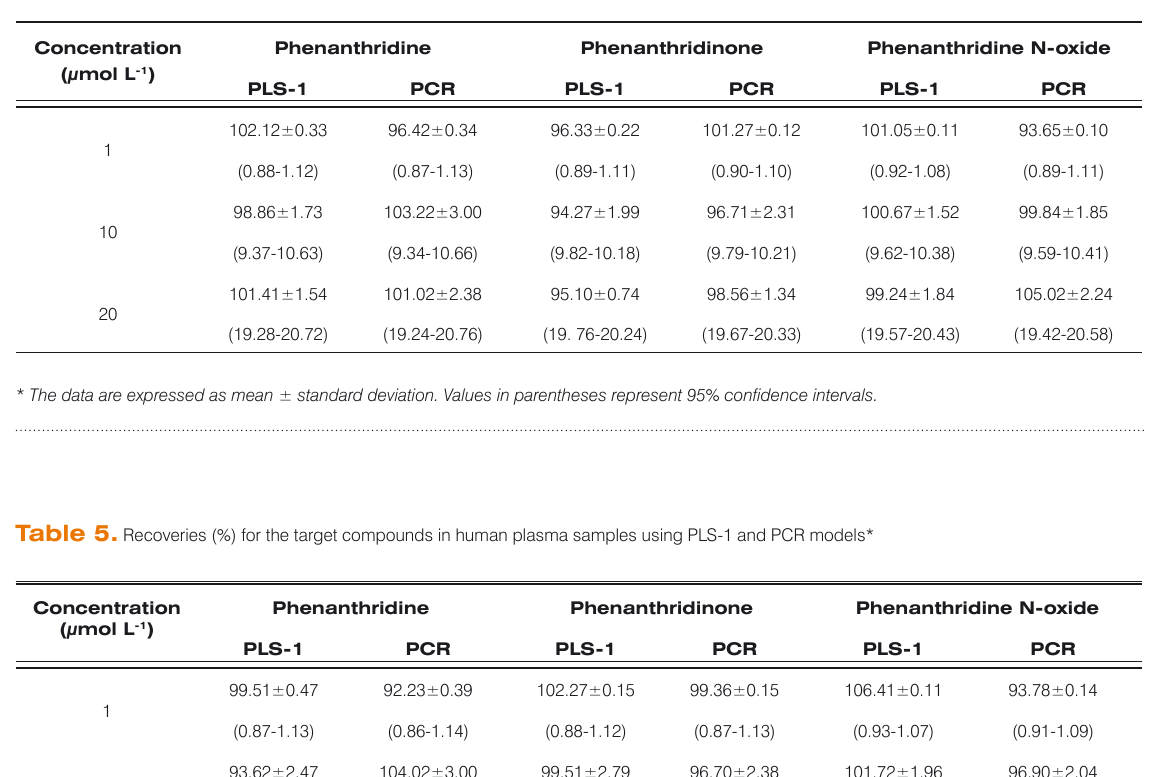
Concentration (μmol L -1 )